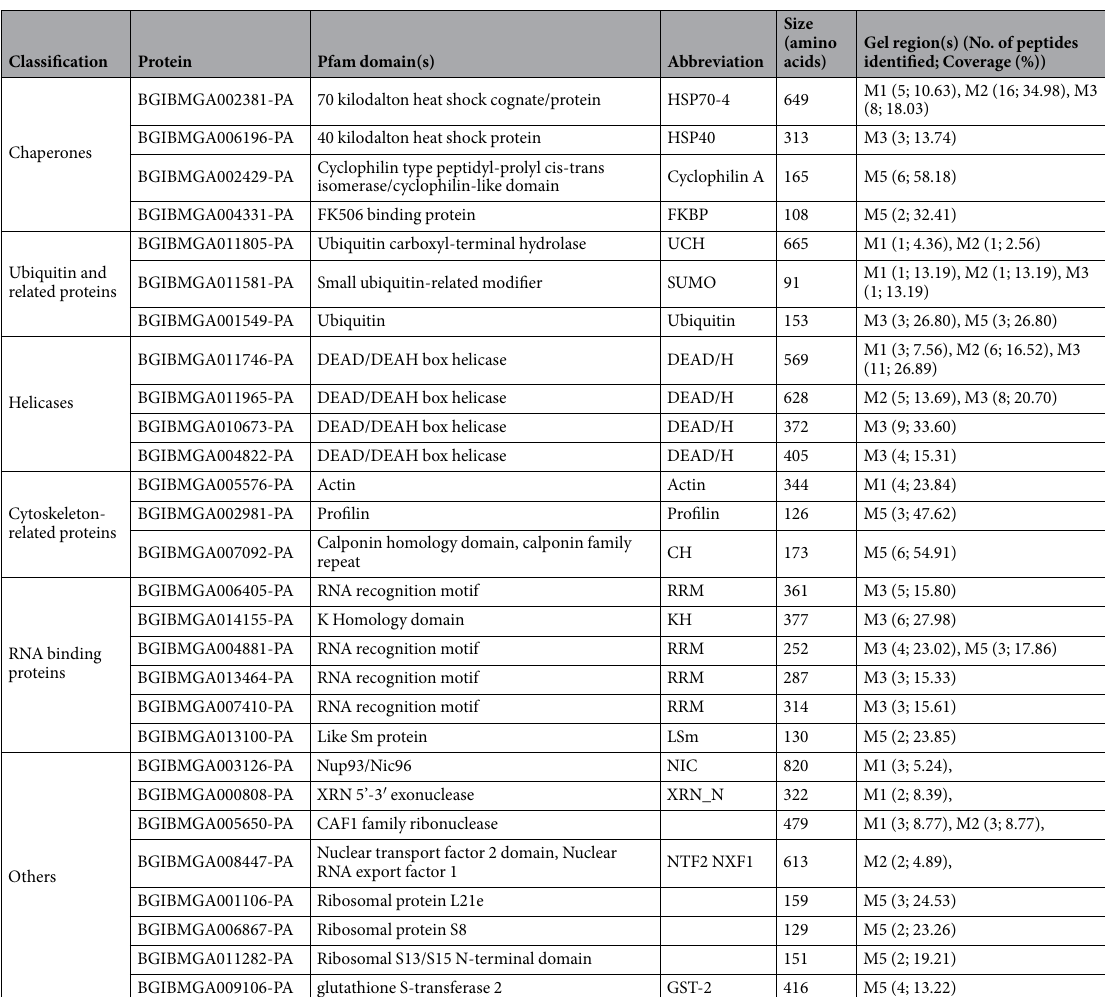
Table 1. Host proteins identified in the BmNPV polyhedral matrix using the LC-ESI-MS/MS Q Exactive visible band was detected (Fig. 3E). Thus, the differences observed in the staining using several antibodies were interpreted as mono- and/or multiple mono-ubiquitination. The LC-ESI-MS/MS analysis identified several ubiquitinated viral proteins, i.e., BV/ODV-C42, DNAPOL and PKIP, although this results should be further confirmed experimentally (Table 3). Ubiquitin exists in several linked forms, and each form plays distinct roles in the cell. Although BmNPV ubiquitin contains an additional and seven conserved lysines 37 , two linked forms, i.e., K48- and K63-linked poly-ubiquitin chains, were identified, whereas for the host ubiquitin, K6-, K11-, K29-, K48- and K63-linked forms were observed (Table 3). Notably, the identification and role exploration of these ubiquitinated proteins in baculovirus replication will be of interest in future investigations. The presence of host cytoskeleton-related proteins, helicases, RNA binding and ribosomal proteins in the polyhedra matrix was not further verified due to a lack of corresponding antibodies. However, progress during the previous decade has revealed that certain viruses recruit numerous host proteins to facilitate each step of the viral replication process. Cytoskeleton-related proteins are one of the largest groups of cellular factors. The cellular actin cytoskeleton is involved in different stages of baculovirus infections 17 . This present study identified certain nucleocapsid proteins, such as P78/83, BV/ODV-C42 and VP80, to be components of the polyhedra matrix. The proteins P78/83 and BV/ODV-C42 are involved in actin polymerization and nucleocapsid traffick- ing 147–149 . VP80 interacts with filamentous actin 103 . Therefore, it is not surprising that actin became trapped in the polyhedra matrix. RNA-binding proteins bind to single or double stranded RNAs and play important roles in RNA splicing, export, stability, localization and translation 150 , thereby exerting significant control over numer- ous cellular functions. The identification of RNA binding proteins was reasonable due to the existence of certain small non-coding RNAs that could perform a structural function in polyhedra crystal formation in the BmNPV polyhedra matrix 151–153 . The present study is the first to report that certain DEAD/DEAH box helicases are com- ponents of the polyhedra matrix. The DEAD/DEAH box helicases are a family of proteins whose purpose is to unwind nucleic acids. The DEAD box helicases are involved in various aspects of RNA metabolism, including